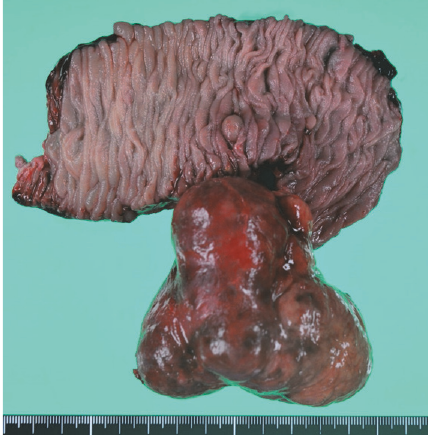
Figure 3: Partial jejunum resection including the lesion was per- formed. The specimen was solid irregular mass that looks like extraintestinal growth